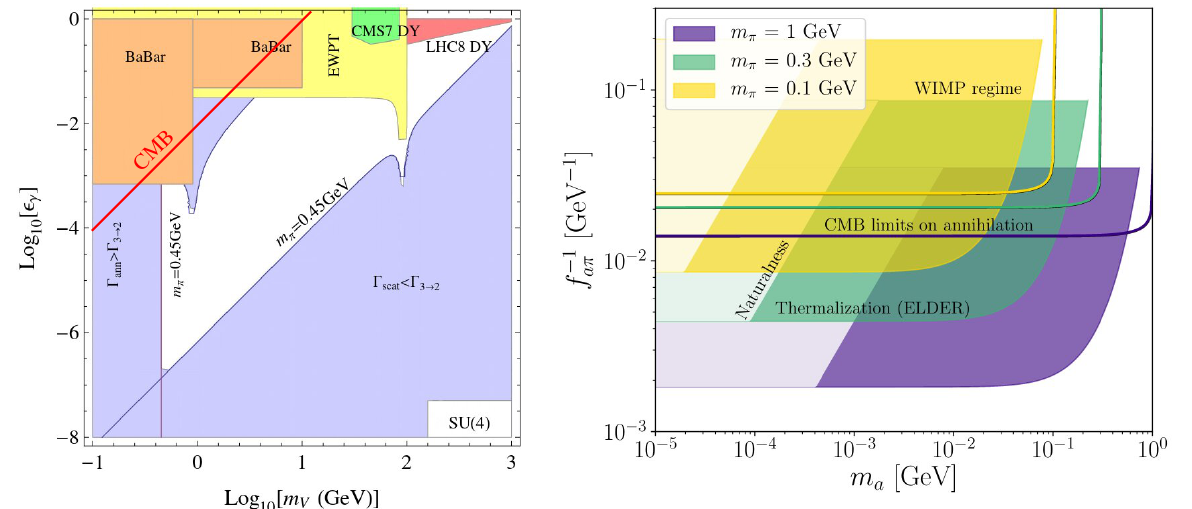
Figure 15: Left: Allowed ranges (unshaded) of kinetic mixing ε versus dark photon mass m for keeping dark pions in equilibrium with the SM during SIMP production, Z (cid:48) adapted from Ref. [ 103 ] . The U(1) (cid:48) gauge coupling is taken to be α (cid:48) = 1 / 4 π . Right: allowed regions (shaded) for axion-mediated thermalization of SIMP-produced dark pions, from Ref. [ 104